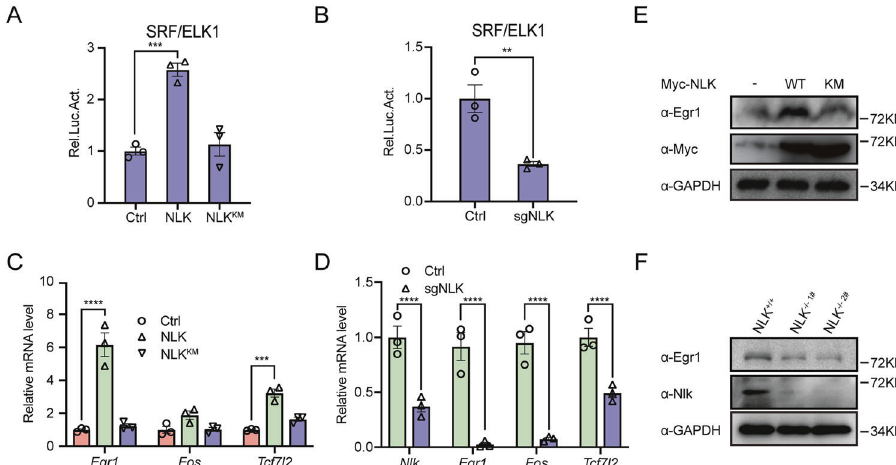
Fig. 3 NLK regulates SRF/ELK signaling in C2C12 cells. A Luciferase assays showing the effects of NLK or NLK KM on SRF/ELK in C2C12 cells. SRF/ELK reporter (200 ng) was cotransfected with an NLK or NLK KM plasmid (200 ng) into C2C12 cells for 36 h, followed by analysis with a luciferase kit assay ( n = 3). B Luciferase assays showing the effects of NLK de fi ciency on SRF/ELK in C2C12 cells. C Real-time PCR showing the effects of NLK or NLK KM plasmid (200 ng) on Egr1, Fos, and Tcf7l2 gene transcription in C2C12 cells. The real-time PCR values were normalized to the Gapdh values ( n = 3). D Real-time PCR showing the gene transcription levels of Nlk, Egr1, Fos, and Tcf7l2 in wild-type and NLK-de fi cient C2C12 cells. The real-time PCR values were normalized to the Gapdh values ( n = 3). E Immunoblotting showing the effects of NLK or NLK KM on Egr1 protein levels using an anti-Egr1 antibody in HEK293T cells. GAPDH was used as a loading control. F Immunoblotting showing the protein levels of Egr1 and Nlk in wild-type and Nlk-de fi cient C2C12 cells using anti-Nlk and anti-Egr1 antibodies. GAPDH was used as a loading control. Data are representative of three independent experiments and presented as the mean ± SEM. Statistical signi fi cance was analyzed by ANOVA (** p < 0.01, *** p < 0.001, **** p < 0.0001). Ctrl control. Source data ( A – F ) are provided as a source data fi